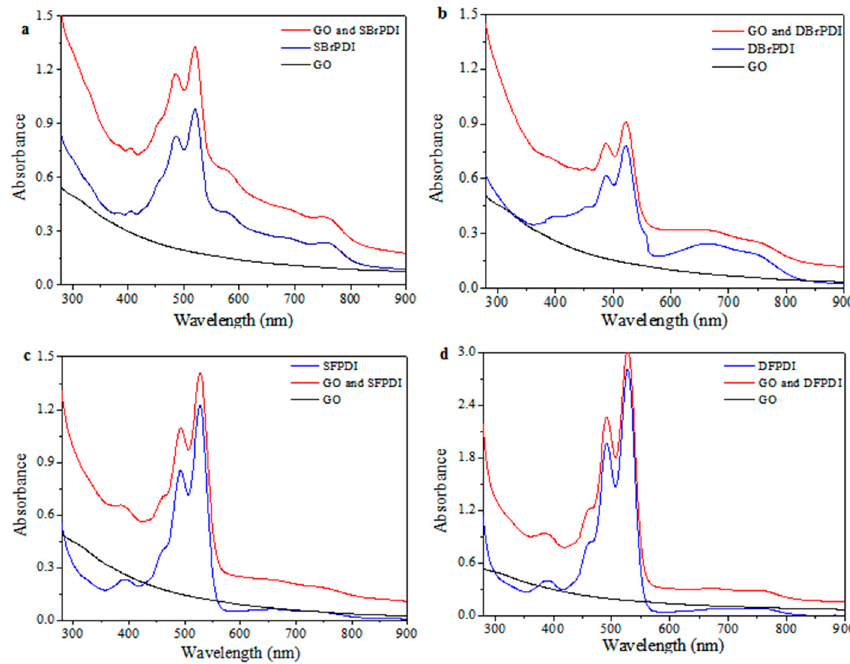
Figure 1. Absorption spectra of perylene diimide derivatives (PDIs), the 1:1 mixture with mass ratio of PDIs/GO and GO in N , N ’-dimethylformamide (DMF) (Concentration of PDIs, C = 10 − 5 M). DBrPDI: N , N ’-diethylhexyl-1,7-dibromo-perylene diimide; DFPDI: N , N ’-diethylhexyl-1,7-dipentafluoro-phenoxyl- perylene diimide; GO: Graphene oxide; SBrPDI: N , N ’-diethylhexyl-1-bromo-perylene diimide; SFPDI: N , N ’-diethylhexyl-1-bromo-7-pentafluorophenoxyl-perylene diimide.